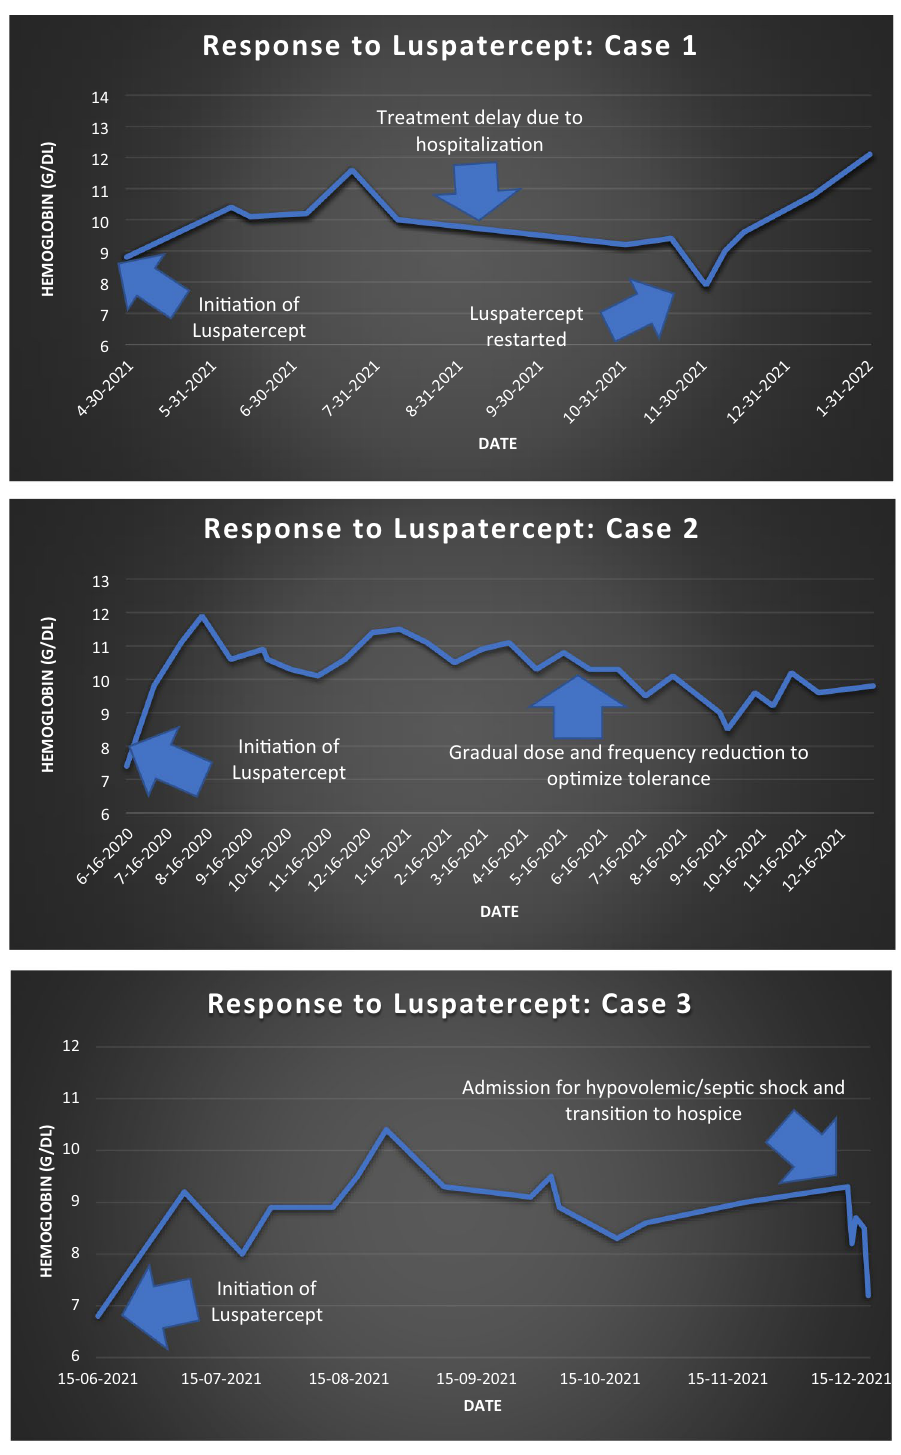
Fig. 2 Graphical representa- tions of hemoglobin response to